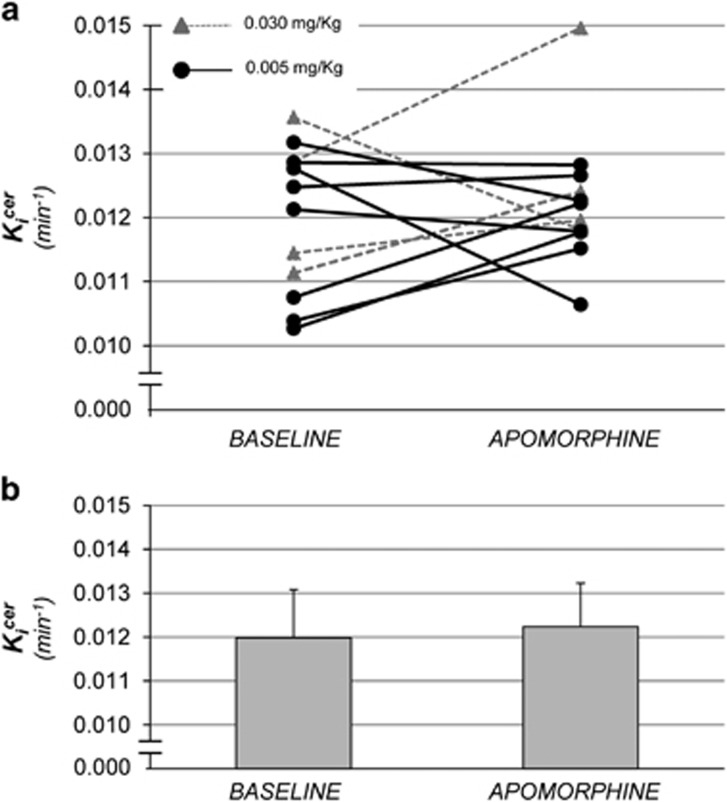
(a) Single-subject dopamine synthesis capacity at baseline and following apomorphine. (b) Mean (s.d.) dopamine synthesis capacity at baseline and following apomorphine.